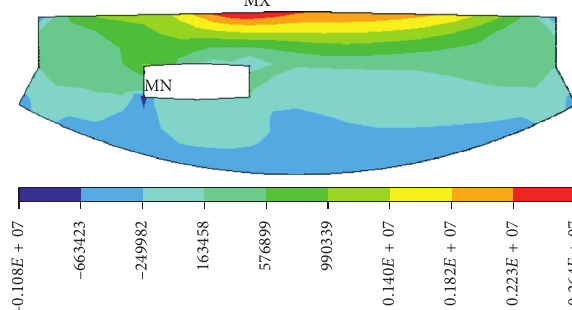
Figure 17: First principal stress of tunnel substructure (Pa) before the